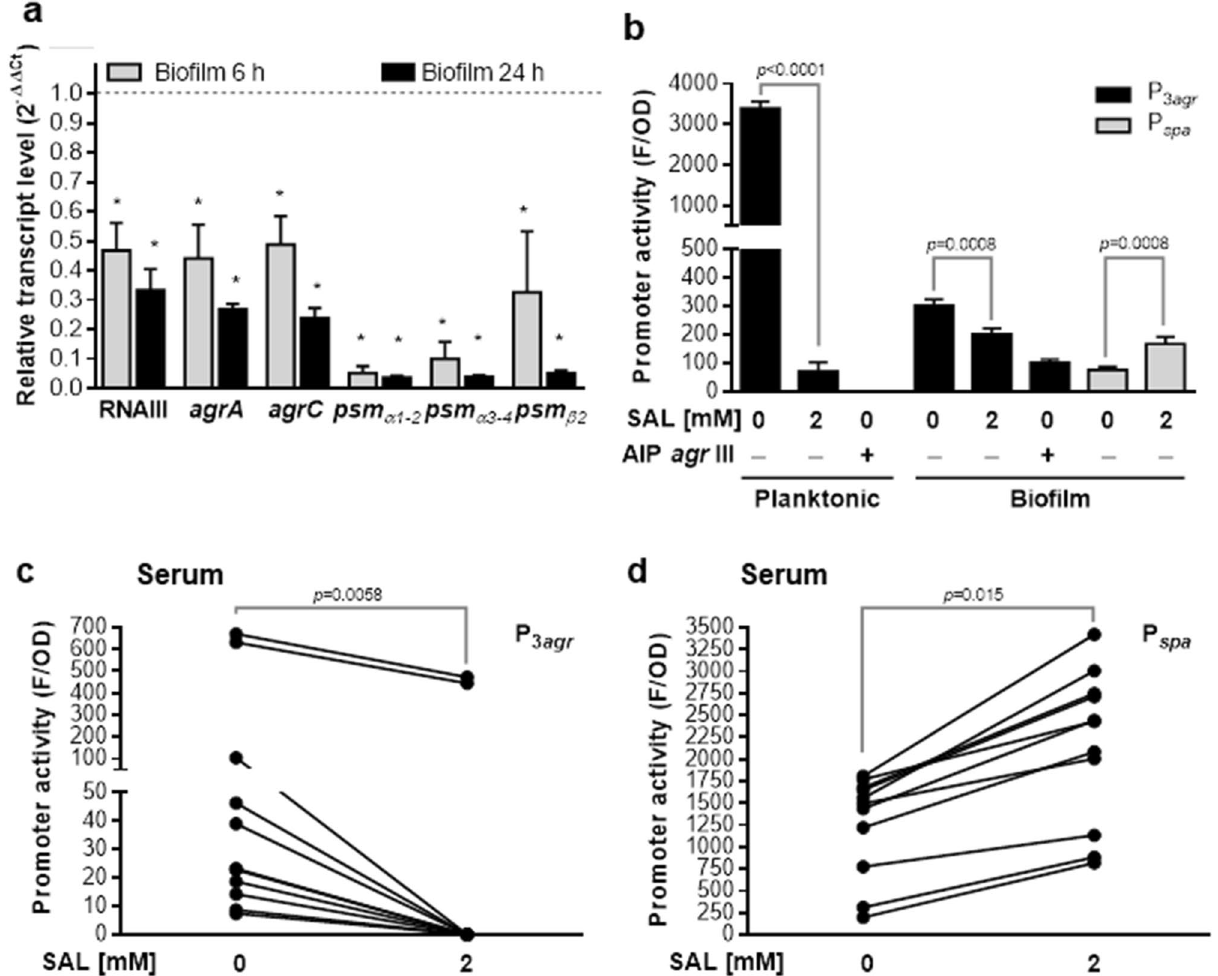
Figure 6. SAL modifies agr, psm and, spa transcription. ( a ) RNAIII, agrA , agrC , psmα 1-2 , psmα 3-4 and psmβ 2 transcripts were quantified in immature (6 h) and mature (24 h) Newman biofilms formed in TSBg with 2 mM SAL. Genic expression changes were informed as fold changes (2 −∆∆Ct ). Data were related to the expression of the housekeeping gene gyrB . Values of 2 −∆∆Ct < 1 represent a decreased expression with SAL treatment. Each bar represents the mean ± SEM from duplicates of 3 independent experiments. The asterisk symbol means a significant change ( t- test). ( b ) Planktonic and biofilms cultures of Newman P3 agr and Newman P spa grown for 24 h in TSBg with 2 mM of SAL or supernatants of S. aureus agr type III cultures, enriched in AIP type III. Promoter P 3 agr y P spa activities were determined by gfp fusion and quantification of fluorescence (F) corresponding to GFP. F values were related to the final growing optical density (OD). Each bar represents the mean ± SEM of 6–8 wells from 3 to 4 independent experiments. Statistical comparisons are represented by lines with the p values denoted above ( t- test). ( c ) Eight-hour planktonic cultures of Newman P3 agr and ( d ) Newman P spa strains grown in human serum from 11 donors with 2 mM of SAL. The lines link each donor represented with a dot, in both conditions and the p values denoted above ( t- SAL downregulates agr and psm expression. Because SAL could interfere with the interaction of AgrA and the genes under its control, the transcriptional profile of genes stimulated by AgrA was analyzed by RT-qPCR. Initially, the level of psm α transcripts was quantified in biofilms formed by the Newman strain and its isogenic agr- defective mutant. The results showed downregulation of psm α in the agr mutant (2 −∆∆Ct psmα 1-2 : 0.0014 ± 0.0006; 2 −∆∆Ct psmα 3-4 : 0.1260 ± 0.0720; p < 0.0001) under the experimental conditions used. To get an insight about the transcriptional state of the agr locus in biofilms exposed to SAL, the agrA , agrC and psm transcripts were quantified by RT-qPCR. The presence of SAL promoted a significant decrease in the levels of transcripts psmα 1-2 , psmα 3-4 and psmβ 2 both in immature (6 h) and mature (24 h) S. aureus biofilms (Fig. 6a). Indeed, RNAIII, agrA and agrC transcripts were also downregulated in biofilms formed with SAL (Fig. 6a). Also, the activity of the P3 agr promoter was significantly decreased by SAL in both planktonic cultures and mature bio- films and SAL enhanced the P spa promoter activity in biofilm lifestyle, which is downregulated by agr 31 (Fig. 6b). Furthermore, the decrease in promoter activity induced by SAL resembled that achieved by the addition of AIP type III, an agr I inhibitor used as a negative control. It should be noted that the Newman strain possesses an